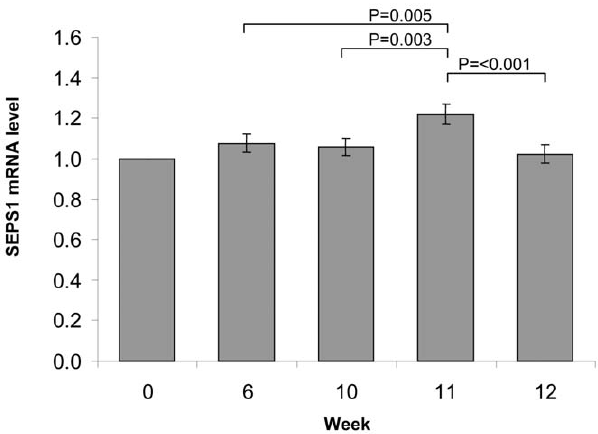
Figure 3. SEPS1 mRNA level in PMBCs measured over the intervention period, each time point showing the mean of all the yeast supplement groups (placebo, 50, 100 and 200 m g/ day). GUSB was used as reference gene for normalisation. Data are presented as mean 6 SEM (n=65 to 71 per time point) relative to baseline, week 0 expression.